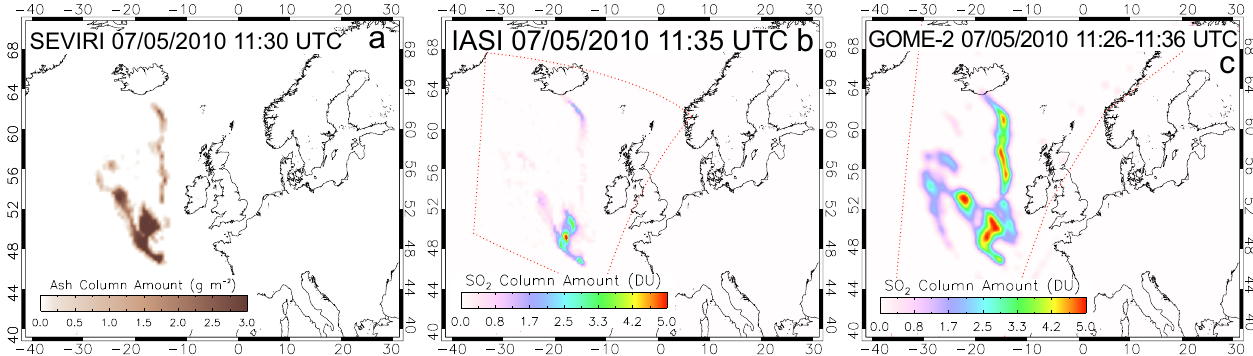
Fig. 4. Ash retrieval for 7 May 2010 from MSG-SEVIRI with the near-coincident retrievals of SO 2 from the IASI and GOME-2 instruments. As before, red dashed lines indicate the swath edge of the polar orbiting instruments (the image limit in the case of IASI).